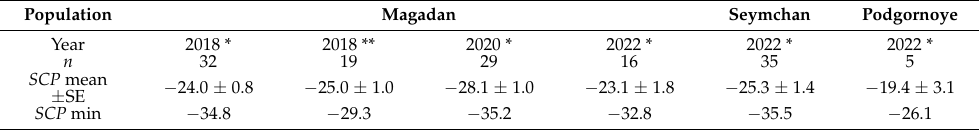
Table 3. Supercooling point ( SCP , in ◦ C) of imago Aglais urticae in different years in three populations. Population